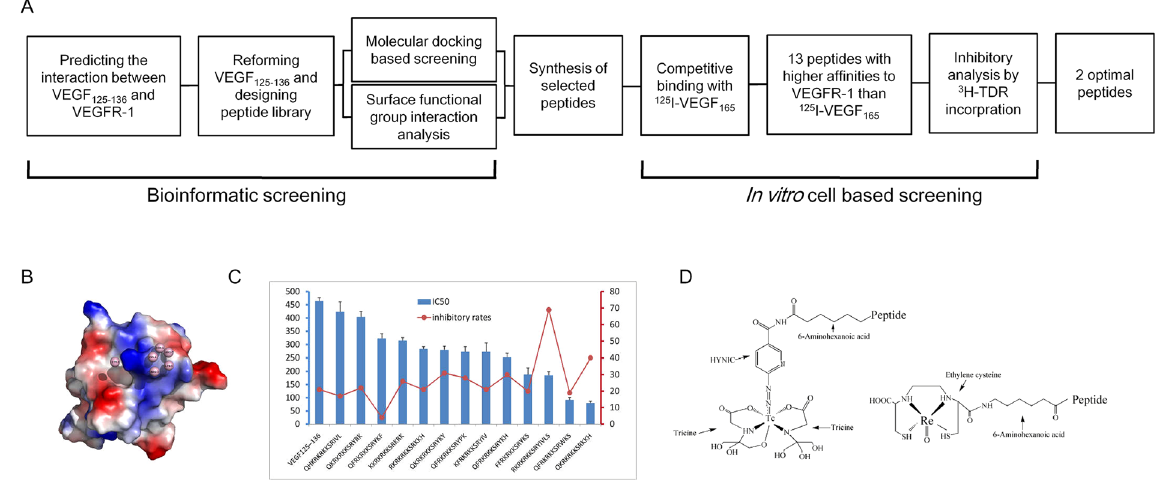
Figure 1. Screening of optimal peptides. ( A ) Flow chart for peptide screening via bioinformatics and cell- based assays. ( B ) Simulated image of VEGFR-1 interacting with the binding core of VEGF 125-136 . ( C ) In vitro competitive binding of the 13 selected peptides with 125 I-VEGF 165 and the 3 H-TDR incorporation assays. ( D ) Structures of the HYNIC- and EC-conjugated peptides.